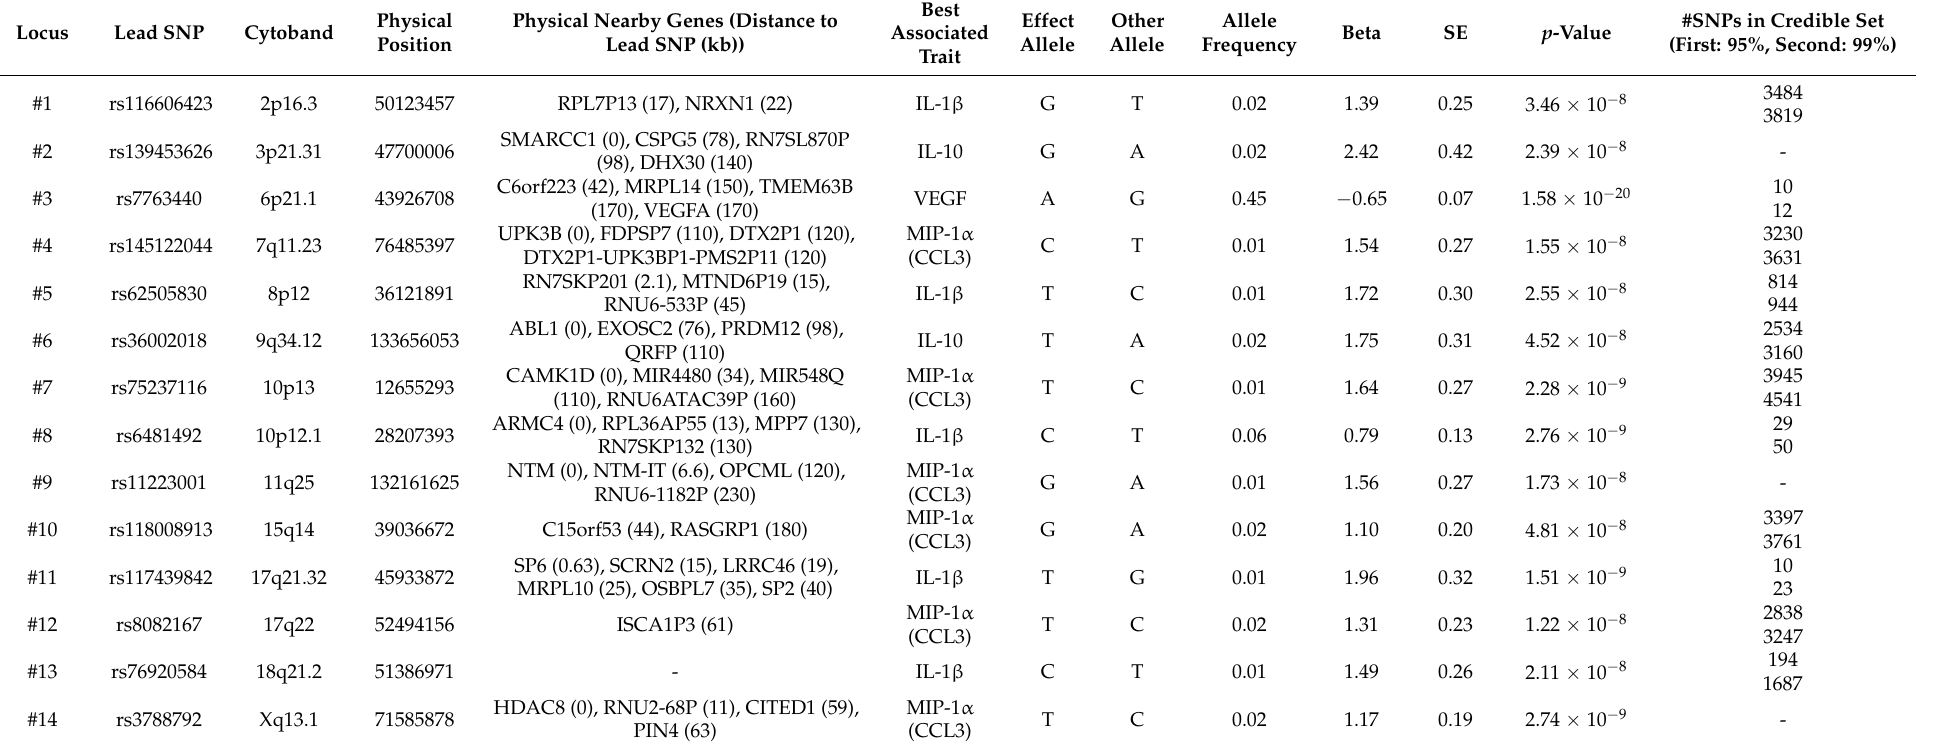
Table 2. Results of genome-wide SNP association analyses. In the table we present all 14 loci with genome-wide significant associations (threshold 5 × 10 − 8 ). For each locus, lead SNP, corresponding cytoband and physical position (GRCh37), physically nearby genes (within ± 250 kb), best associated trait, effect allele, other allele, effect allele frequency, and beta estimate of the additive model with standard error and p -value for the top associated cytokine are shown. We also present the size of the respective 95% and 99% credible sets. For loci 3p21.31, 11q25, and Xq13.1 the lead SNPs showed minor allele frequencies below 1% in the complete data set and, thus, were excluded from the reference data set for conditional and joint analysis and credible set analysis resulting in empty cells in the corresponding rows. Loci are presented in the order of their chromosomal